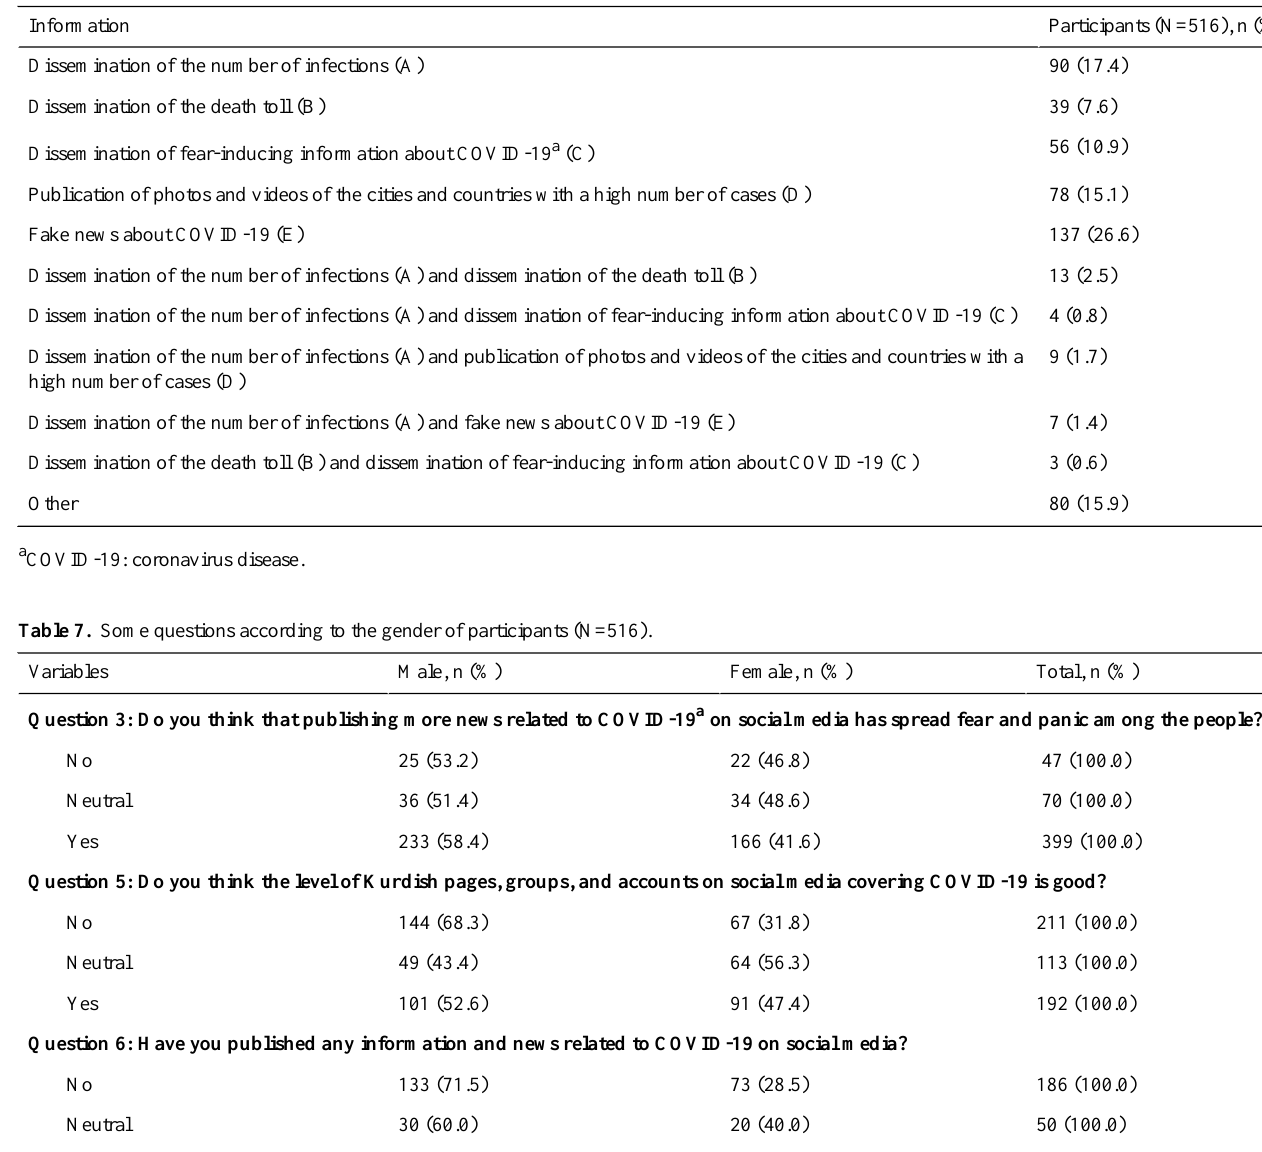
Table 6. Categories of information shared on social media.